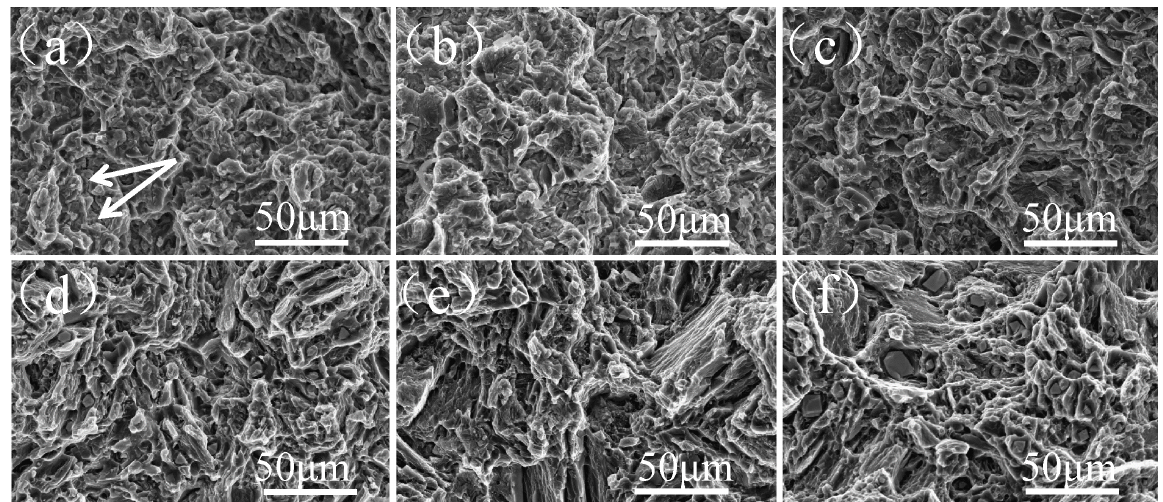
Figure 6. Fracture morphology of as-cast Mg-11Gd-2Y-1Zn-xAl alloys. ( a ) x = 0; ( b ) x = 1; ( c ) x = 2; ( d ) x = 3; ( e ) x = 4; ( f ) x = 5.